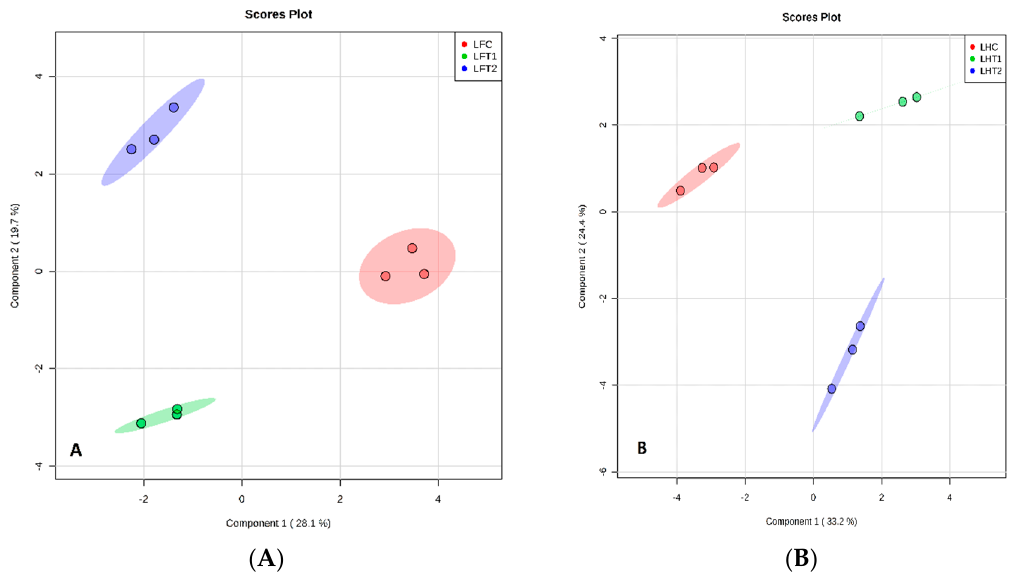
Figure 3. Sparse partial least squares discriminant analysis (sPLS-DA) model obtained from the classification of leaves from Floribunda and Hybrid Tea roses samples based on volatile organic compounds (VOCs) according to BA treatments. ( A ) Score plot of Floribunda and ( B ) score plot of Hybrid Tea leaves. Red, green and blue colors indicated groups of treatments. L represents Leaves, F represents Floribunda, H represents Hybrid Tea. While C represents control, T1 and T2 represent 100 and 200 mg/L BA, respectively. Three dots in each group mean n = 3 biological replicates.